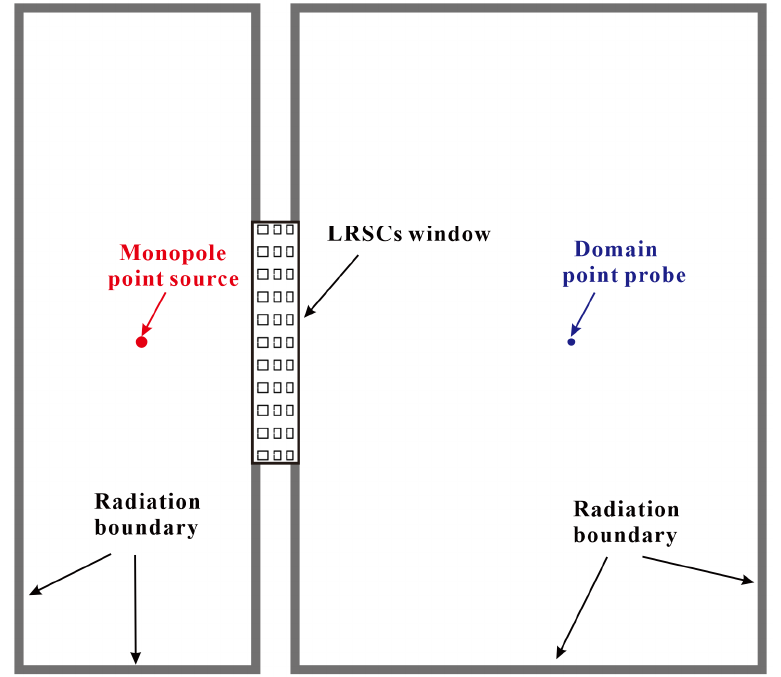
Figure 3. Boundary conditions applied in the 2D numerical model. Table 3. Parameters of the grid system in simulations.